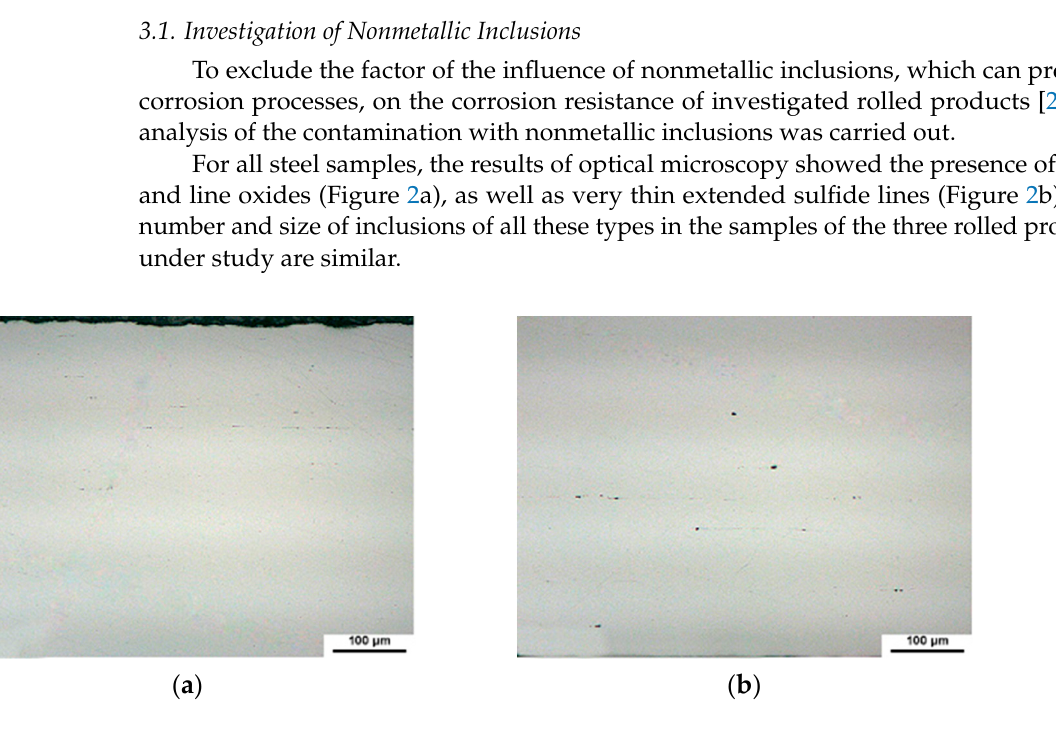
Figure 2. Nonmetallic inclusions in the samples of the batches: ( a ) Point and line inclusions (No.